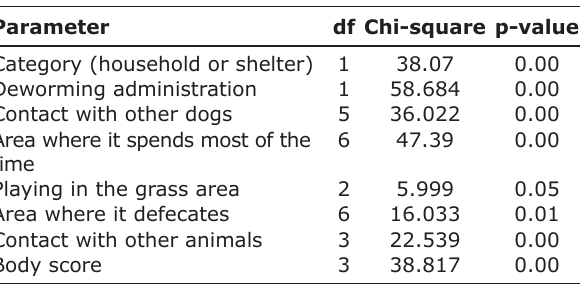
Table-3: Association of the different risk factors with the presence of parasites. Parameter df Chi-square